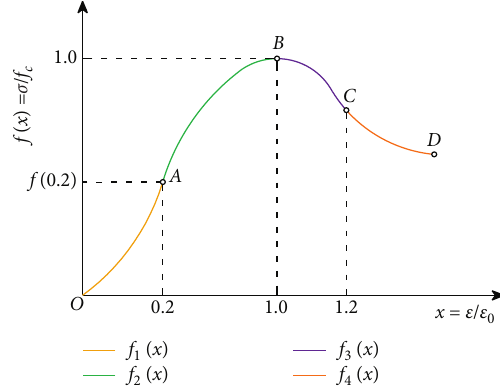
Figure 20: Segmentations of curves.